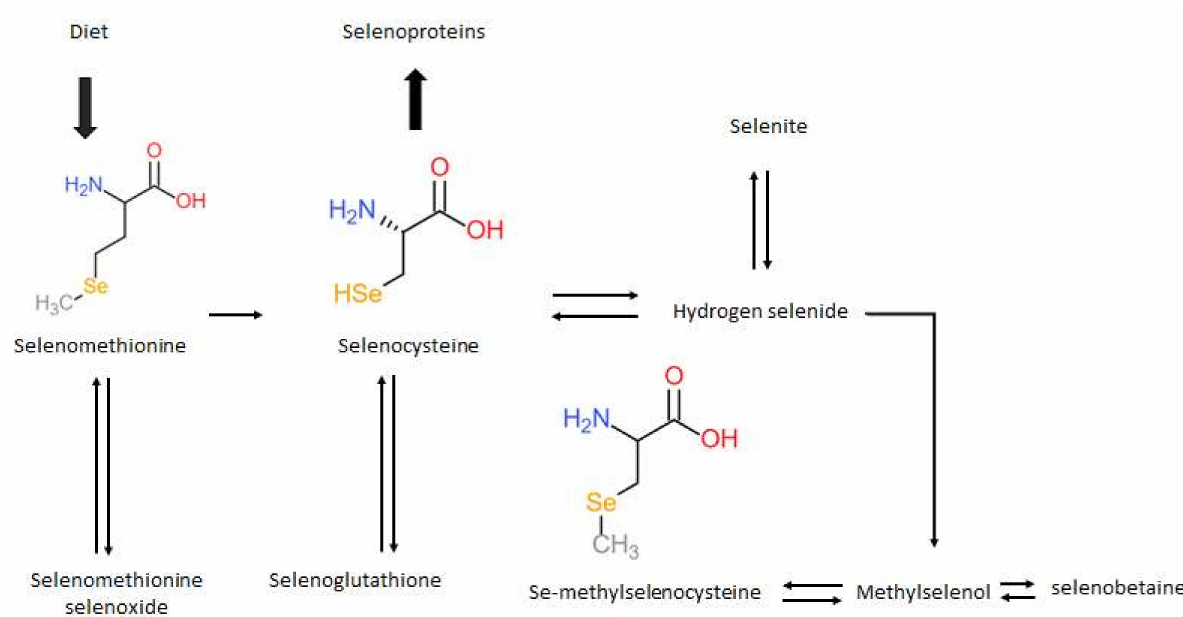
Figure 2. Summary of the metabolism and structures of major dietary organoselenium compounds.